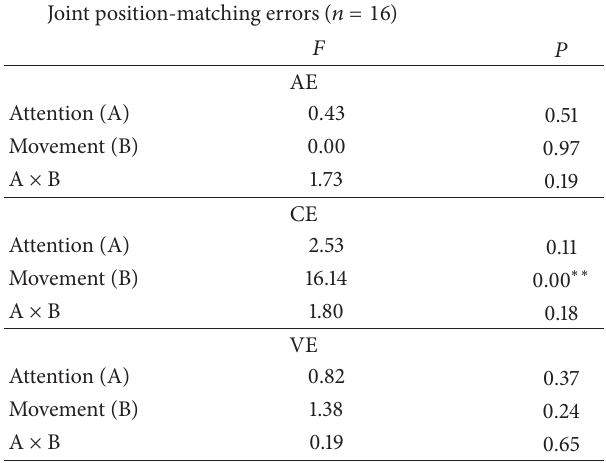
Table 2: Two-way ANOVA results of the joint position-matching error parameters in experiment 1a. 𝑃 values derived from ANOVA for the main effects of attention and movement. Interaction between attention and